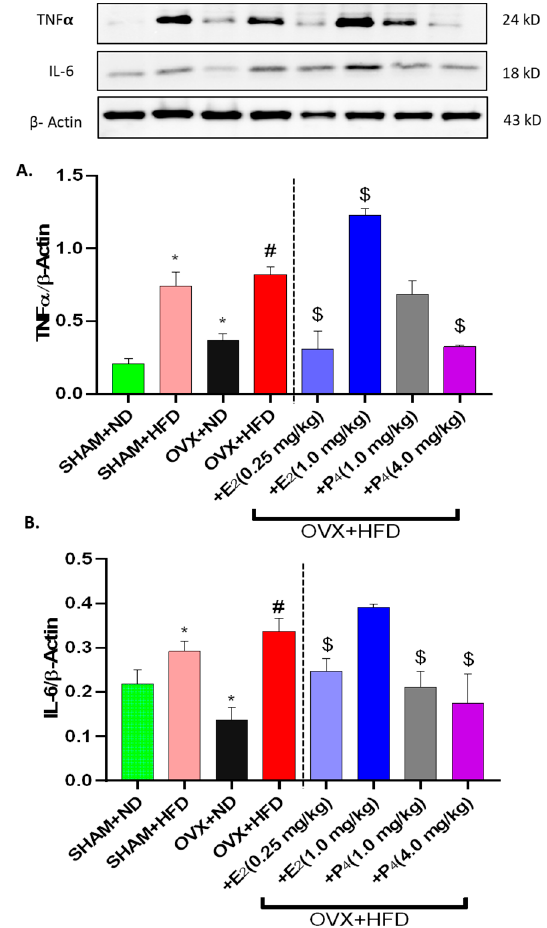
Figure 5. E ff ect of 17 β -Estradiol (E 2 ) and Progesterone (P 4 ) on pro-inflammatory markers, interleukin-6 (IL-6) and tumor necrosis factor- α (TNF α ) protein expression in HFD-fed OVX mice. Representative immunoblot and densitometric analysis data for ( A ) TNF α , ( B ) IL-6 in female mice gastric neuromuscular tissues. Stripped blots were re-probed with β -actin. Data were normalized with housekeeping protein ( β -actin). Bar graphs showed a ratio of target gene or protein with β -actin. Data were analyzed using one-way ANOVA by using graph pad prism software. The values are mean ± SEM ( n = 4). * p < 0.05, significantly different from normal diet-fed sham-operated (SHAM+ND) mice. # p < 0.05, significantly different from normal diet-fed ovariectomized (OVX+ND) mice. $ p < 0.05, significantly different from high-fat diet-fed OVX (OVX+HFD) mice.